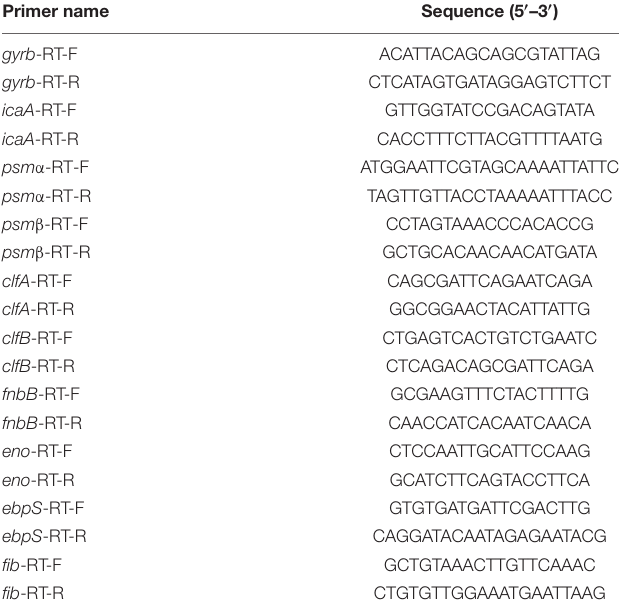
TABLE 2 | Primers used for real-time